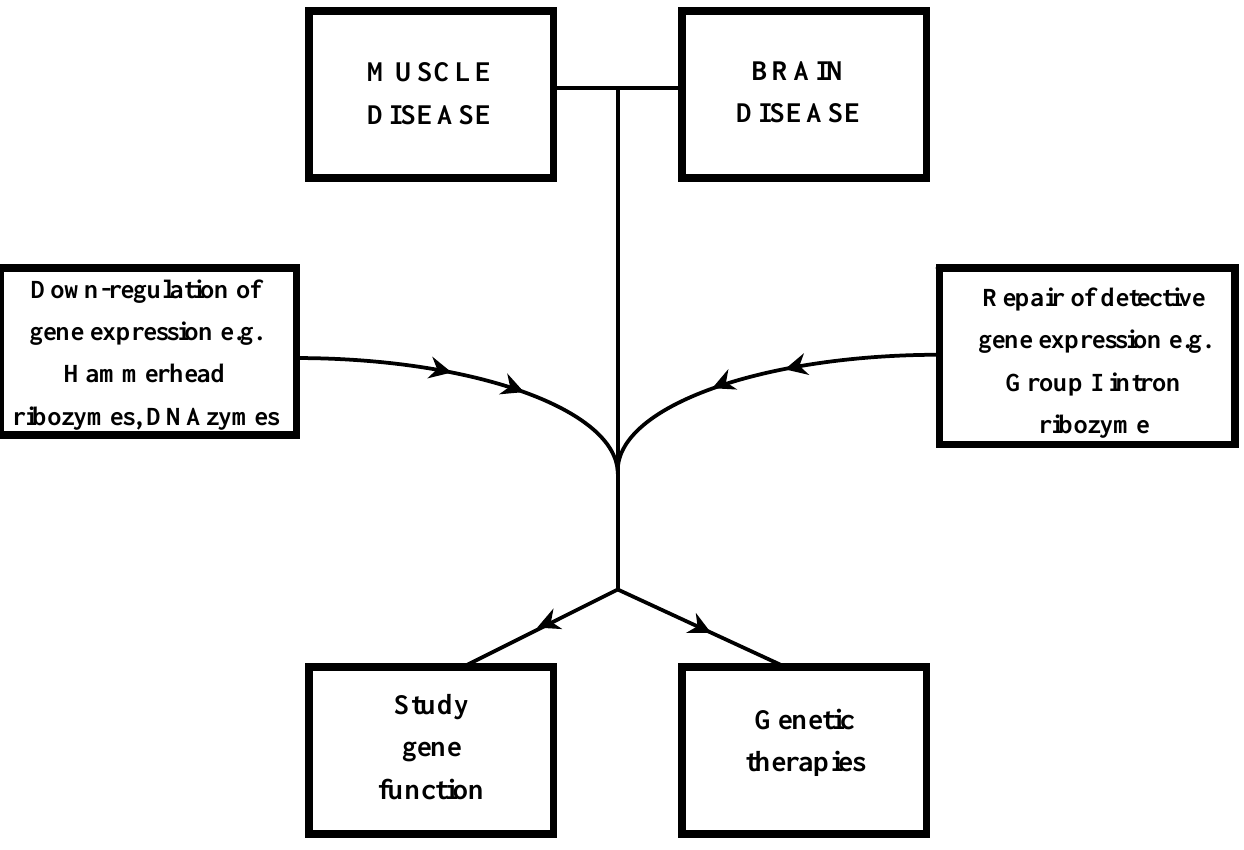
Figure 1. Strategies for the study or therapy of muscle and brain diseases by using ribozymes and DNAzymes.